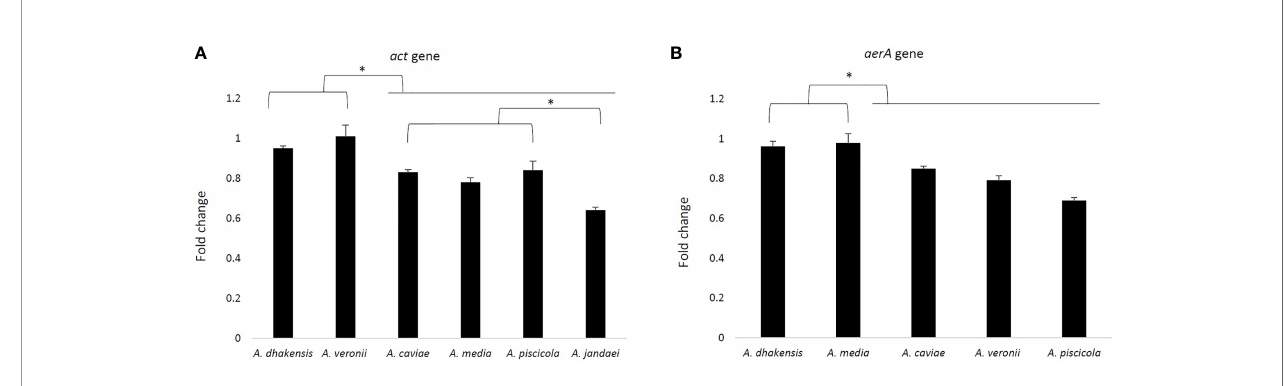
FIGURE 5 | Fold change of the act gene expression pro fi le of six Aeromonas strains (one strain for each species) (A) and the aerA gene with the exception of A. jandaei (B) after 3 h of THP-1 infection, analyzed by RT-qPCR and normalized to the reference gene 16S rRNA. Asterisks indicate a signi fi cant difference (*p